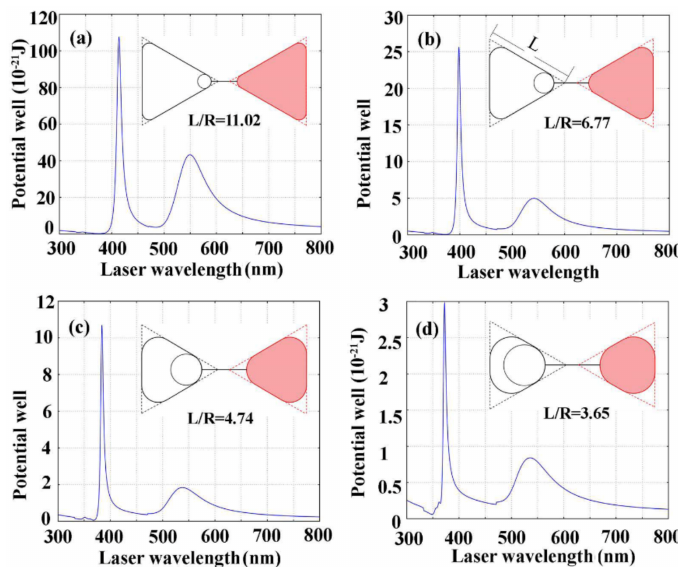
Figure 5. The wavelength-dependent plasmonic trapping potential tunability for the heterogeneous Au–Ag bowtie dimers with respect to the aspect ratio of edge/tip rounding. The aspect ratio of edge/tip rounding is 11.02 ( a ), 6.77 ( b ), 4.74 ( c ), and 3.65 ( d ), which corresponds to tip rounding radii of 2.15 nm, 3.5 nm, 5 nm, and 6.5 nm,